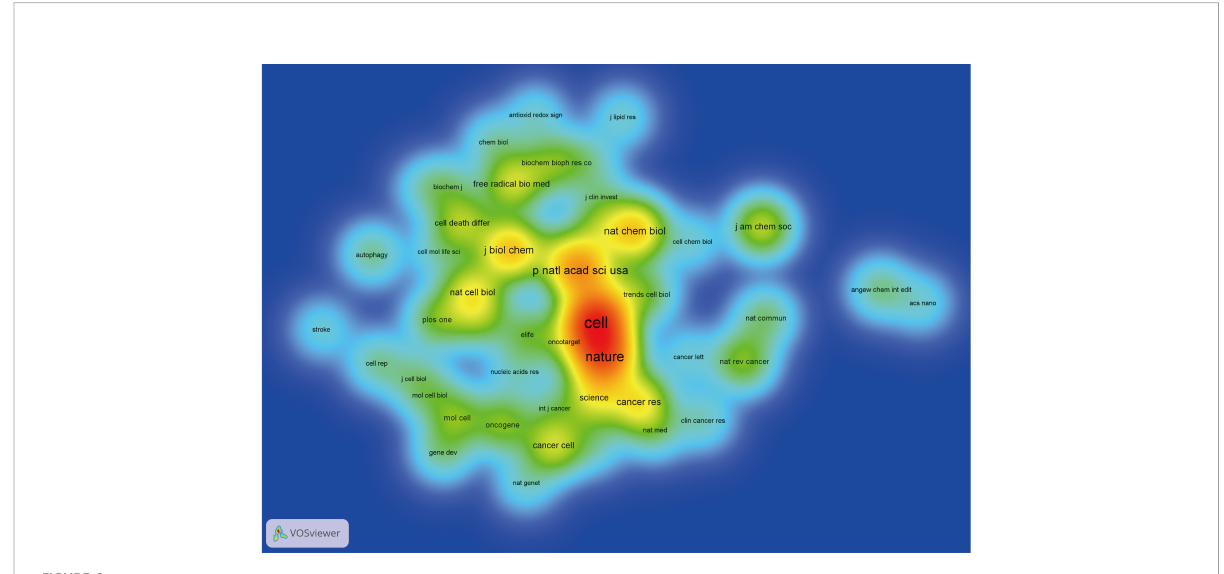
FIGURE 6 Density visualization map of journal co-citation